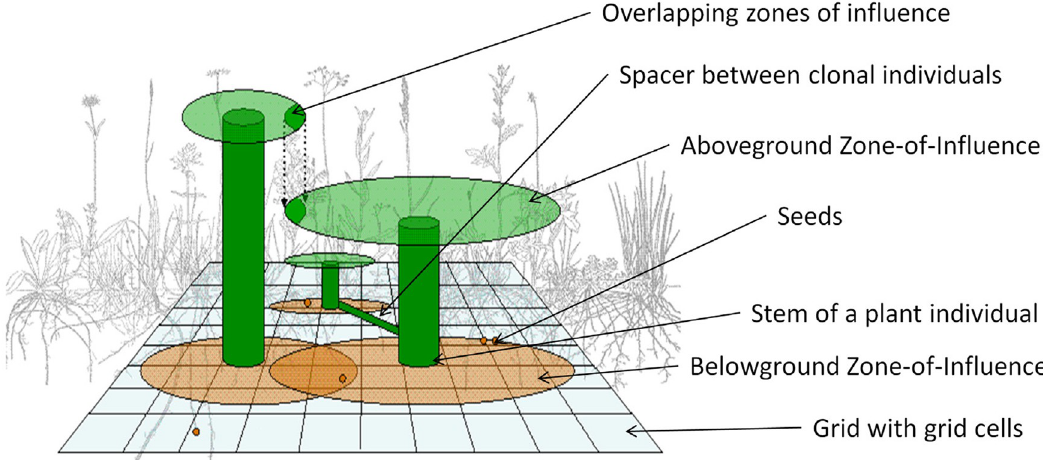
Fig 2. Graphical scheme of the IBC-grass model. Graphic is adapted from Weiß